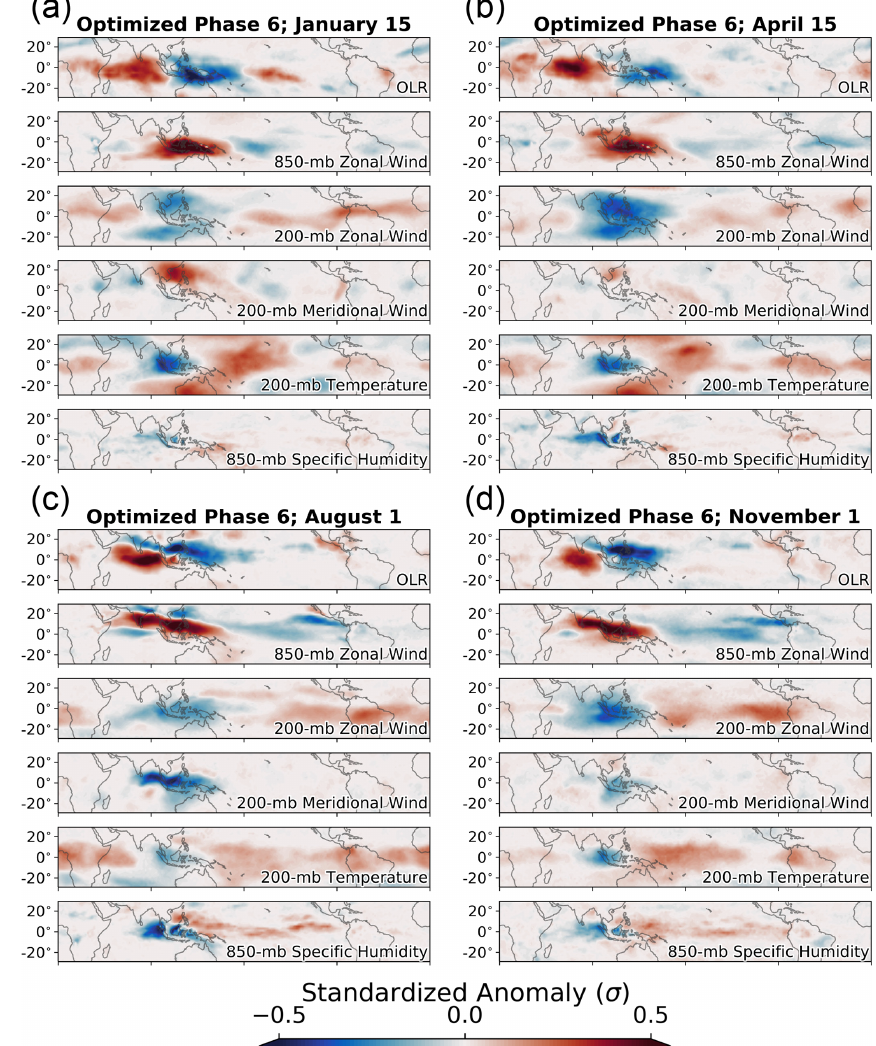
Figure 9. Optimized patterns for phase 6 of the MJO for different periods of the year. The central date on which the neural network is trained for each optimization is shown in the title of each subfigure. Each subfigure shows outgoing longwave radiation, 850mbar zonal wind, 200mbar zonal wind, 200mbar meridional wind, 200mbar temperature, and 850mbar specific